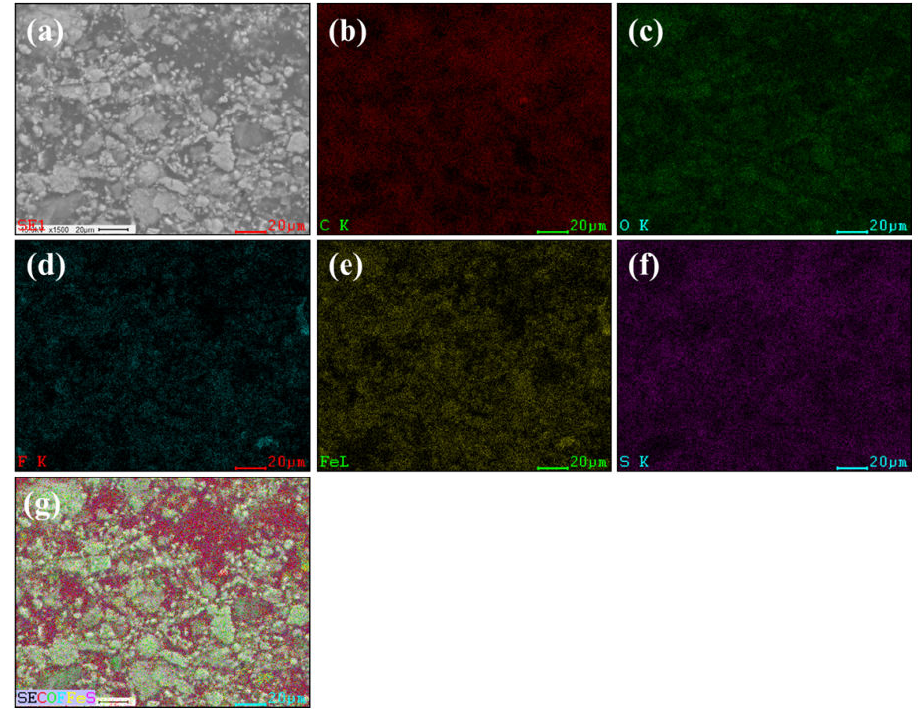
Figure 7. ( a ) FE-SEM selected area of XY/Fe 3 O 4 -9, ( b ) carbon, ( c ) oxygen, ( d ) fluorine, ( e ) iron, ( f ) sulfur, and ( g ) overlapping of